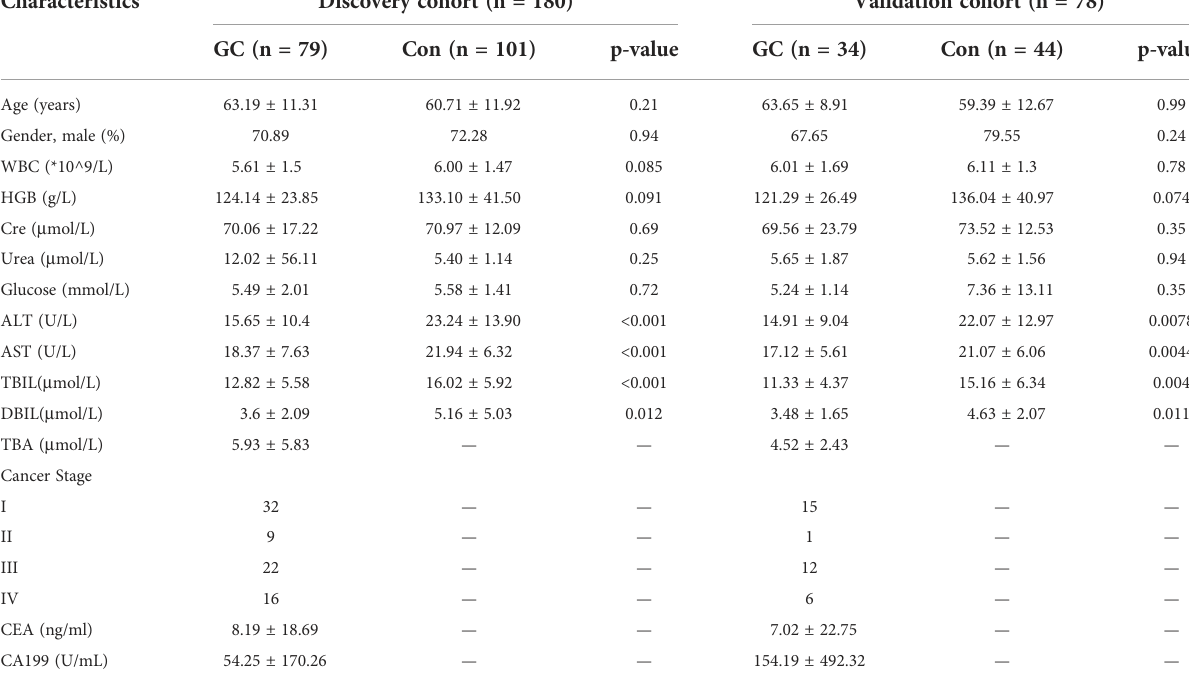
TABLE 1 Patient characteristics for the discovery and internal validation cohorts.